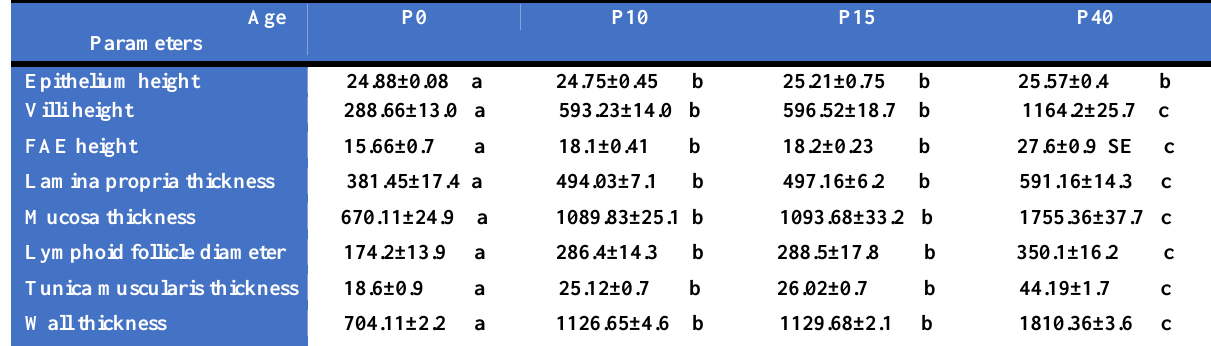
Table, 2: Micromorphometric measurements of different parameters of SR/ µm at different postnatal ages in rabbit.